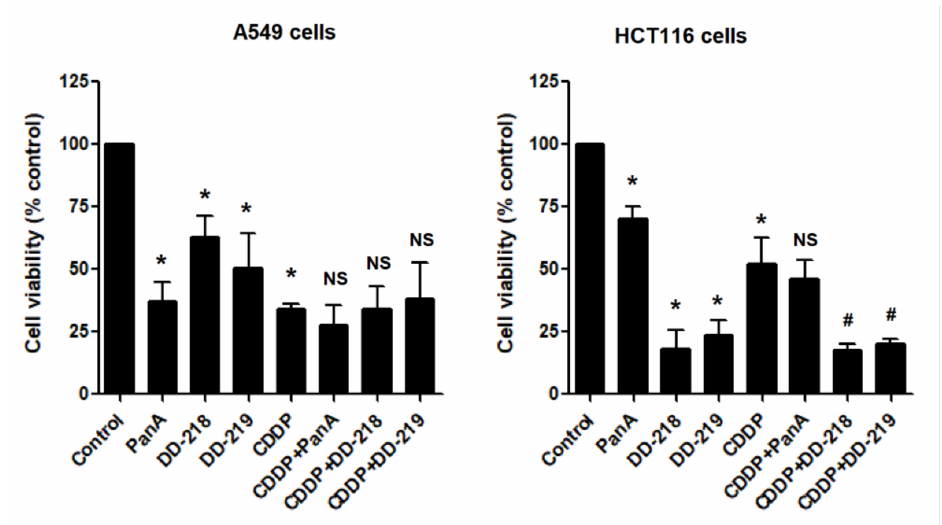
Figure 3. Effects of panduratin A (PanA), DD-218, and DD-219 on the cytotoxicity of CDDP on cancer cell lines. Viability of A549 cells and HCT116 cells was measured following treatment for 72 h with: 0.1% DMSO (control); 5 µ M PanA; 5 µ M DD-218; 5 µ M DD-219; 50 µ M CDDP; 50 µ M CDDP in the presence of 5 µ M PanA (CDDP+PanA); 5 µ M DD-218 (CDDP+DD-218); 5 µ M DD-219 (CDDP+DD-219). Percentage of cell viability is shown as mean + SD from at least 3 independent experiments: * p < 0.05 compared to control; # p < 0.05 compared to CDDP treatment; NS indicates non-significance compared to CDDP